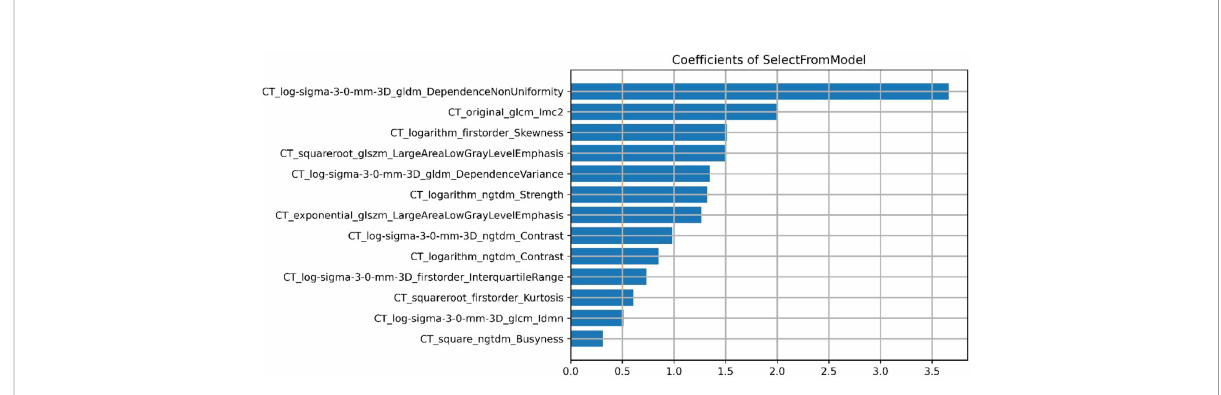
FIGURE 3 The fi nal selected 13 features (3 fi rst-order statistical features and 10 textures).